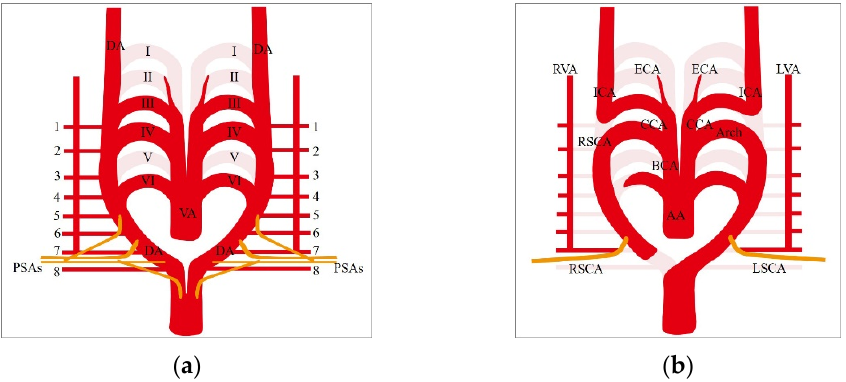
Figure 1. Drawing of the embryologic development of the aorta and brachiocephalic vessels. ( a ) Basic pattern of the development of vertebral artery and major branches of the aortic arch ( b ) Common branching pattern of major aortic branches and the vertebral arteries in the human adult. I–VI, the first to sixth aortic arches; 1–8, the first to eighth segmental artery; VA, ventral aorta; DA, dorsal aorta; PSAs, primary subclavian arteries; ECA, external carotid artery; ICA, internal carotid artery; CCA, common carotid artery; R (L)VA, right (left) vertebral artery; R (L) SCA, right (left) subclavian artery; BCA, brachiocephalic artery; AA, ascending aorta; Arch, aortic arch.